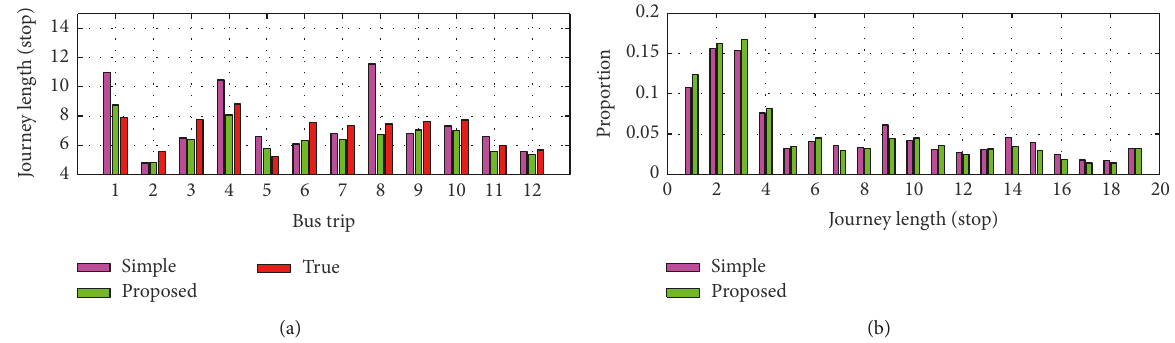
Figure 4: Passengers’ journey length: (a) average journey length by bus trip; (b) distribution of journey length.